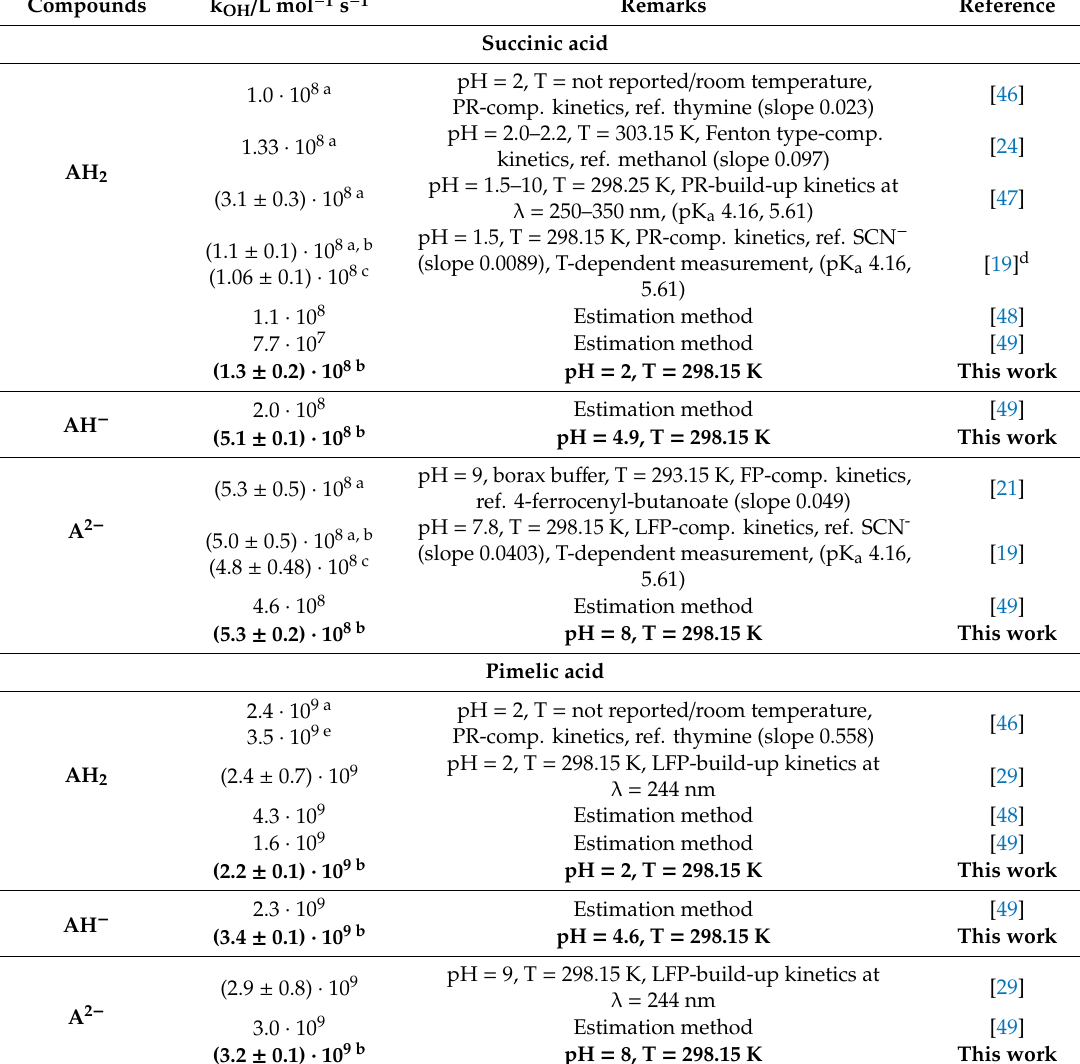
Table 4. Second-order kinetic rate constants for the reactions of the studied dicarboxylic acids with OH in aqueous solution. Bold printing corresponds to data from the present study.